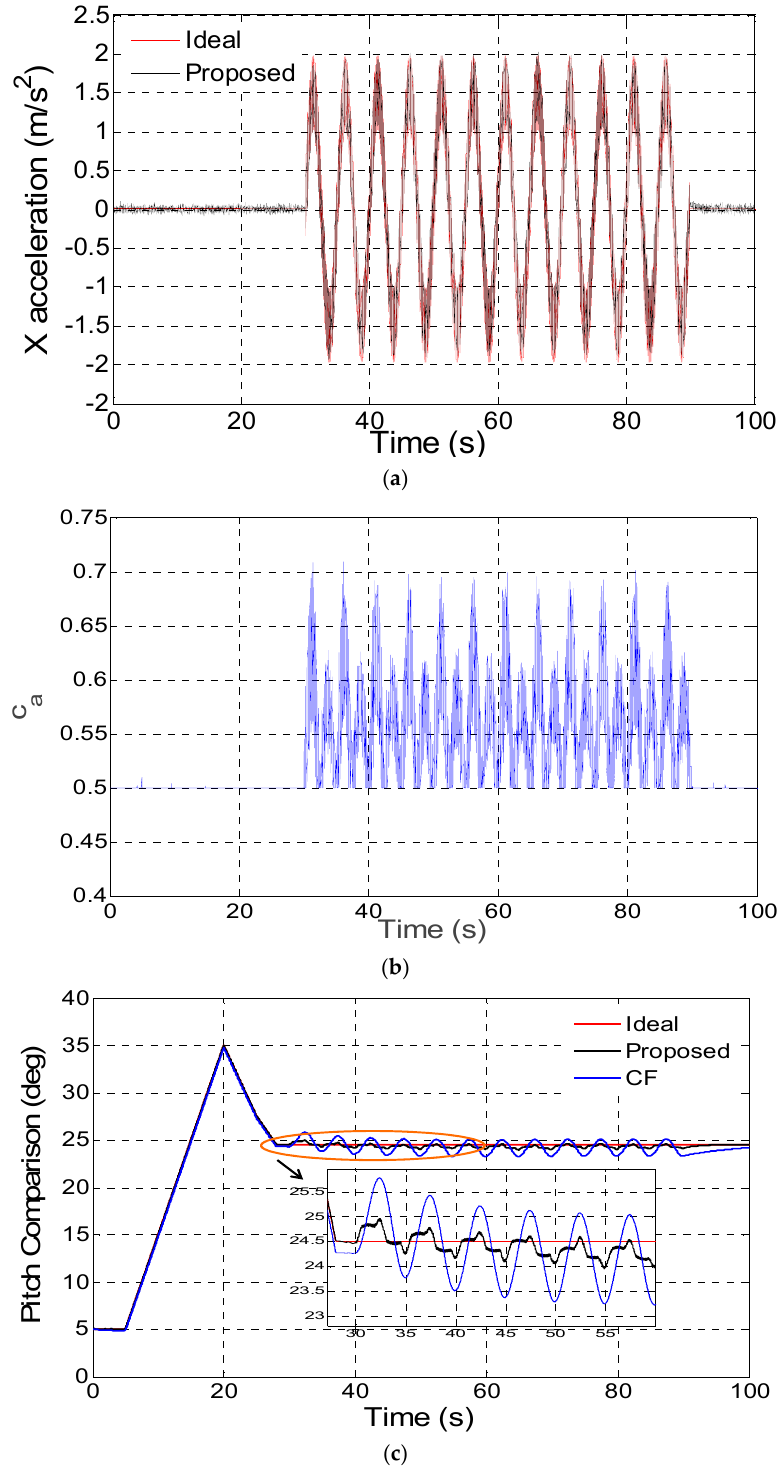
Figure 4. ( a ) X axis disturbance acceleration estimation on body frame in vibration-acceleration mode; ( b ) Adaptive switch for c a in vibration-acceleration mode; ( c ) Pitch estimate comparison in vibration-acceleration mode.